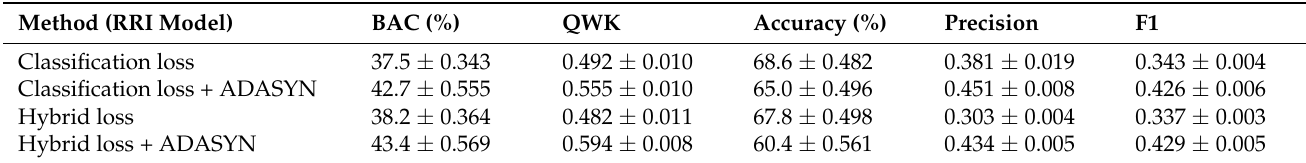
Table 12. Mean and 95% CI of the prediction performance of the RRI model using different sample